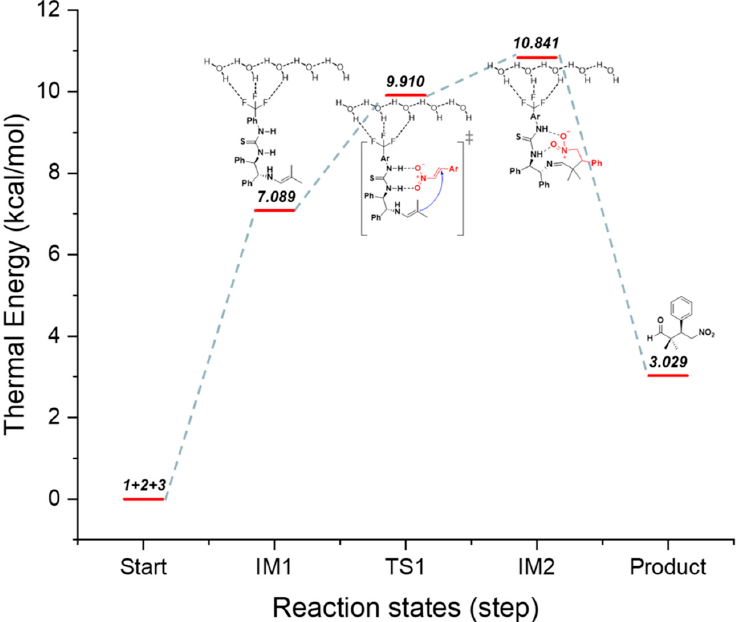
Figure 7. Proposed catalytic mechanism based on the B3LYP/6-31G(d,p) method and the water solvent + H 2 O conditions. The thermal energy diagram of the ( R , R )-1,2-diphenylethylene diamine(DPEN)-thiourea-catalyzed enantioselective Michael reaction.